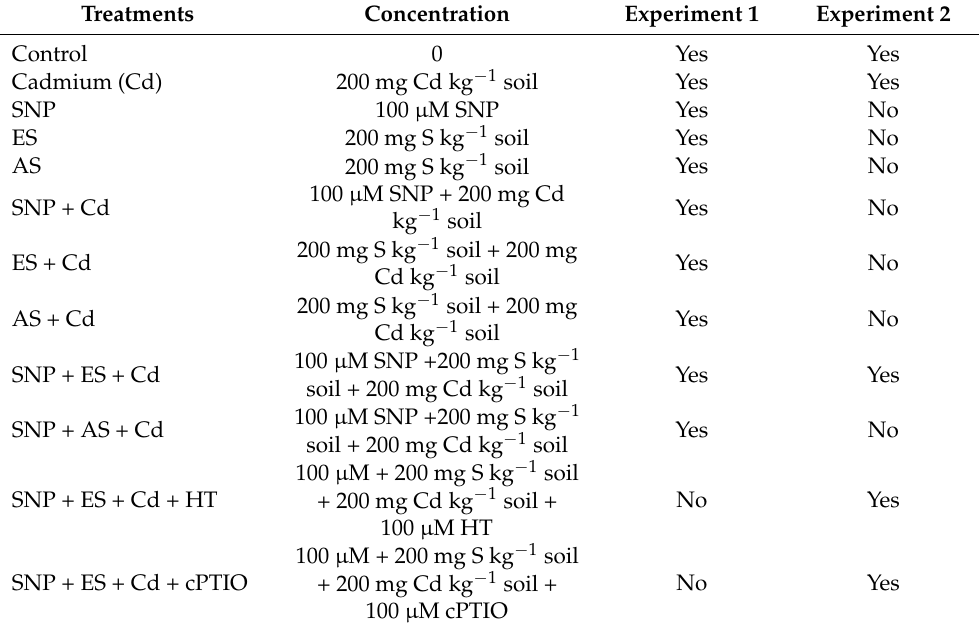
Table 1. Experimental design. Treatments Concentration Experiment 1 Experiment 2 Control